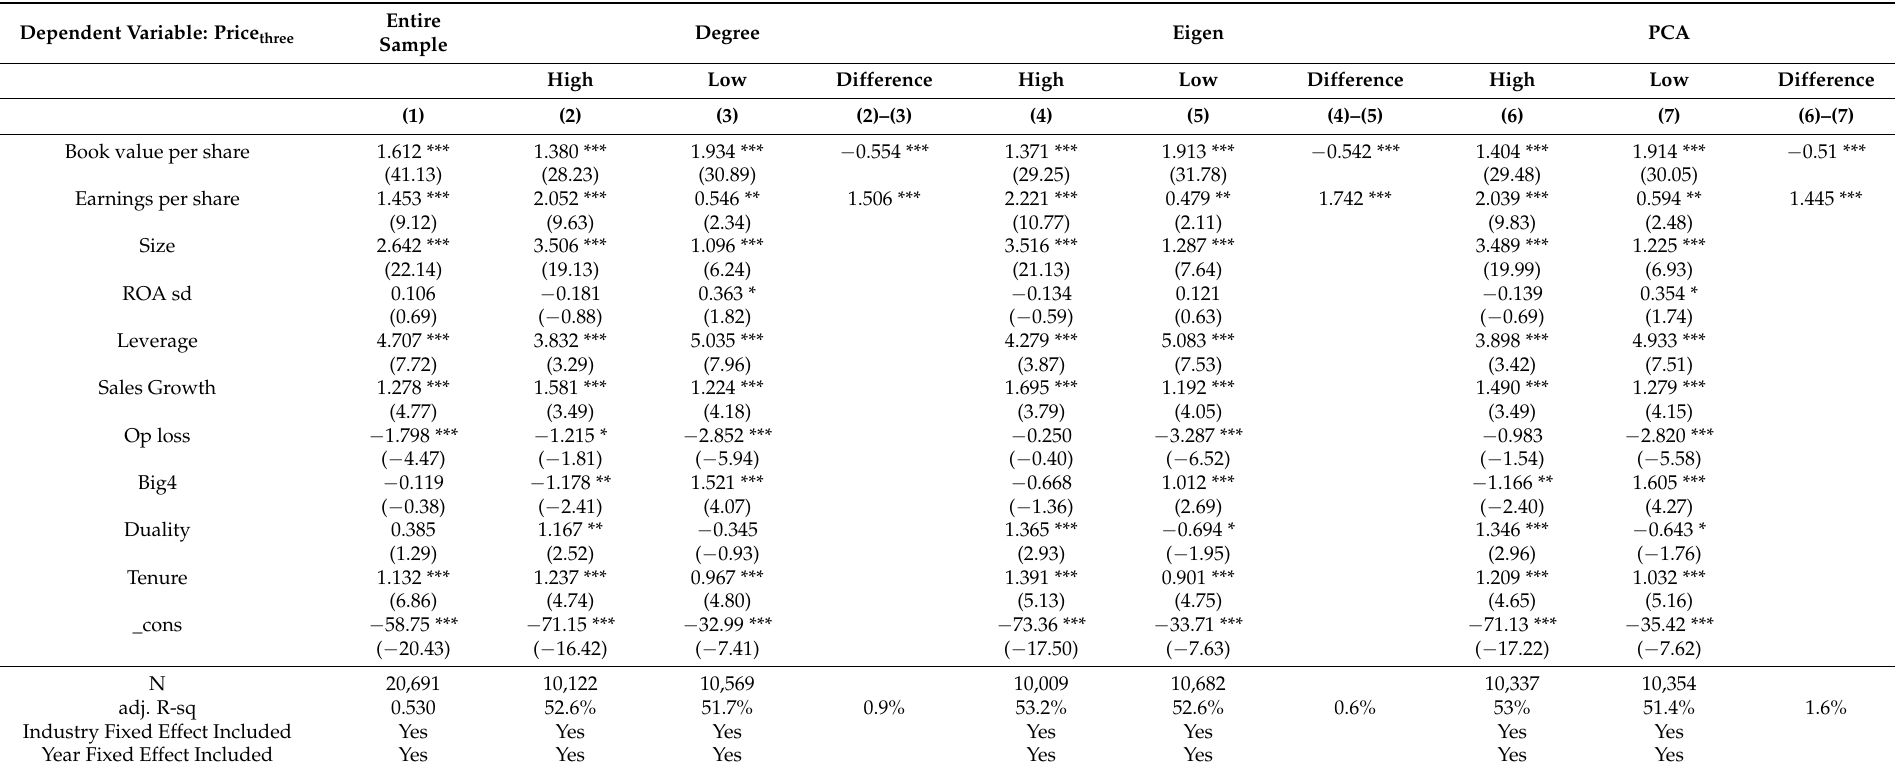
Table 3. CEO social capital and the value relevance of accounting metrics. This table presents the results of the OLS regressions, explaining the effect of CEO social capital on the value relevance of book value of equity and earnings metrics. The dependent variable is Price three , a continuous variable measured by the market price of the common equity at the end of three months after fiscal year-end. CEO social capital is measured by Degree in columns (2) and (3), Eigen in columns (4) and (5) and PCA in columns (6) and (7); variables of interest in the regression include Book value per share (book value of common equity scaled by number of shares outstanding) and Earnings per share (net income scaled by number of shares outstanding). All regressions include control variables as defined in Appendix A. All regressions include time- and industry-fixed effects and the errors are robust to firm heteroscedasticity. T-values are reported in parentheses. Statistical significance of the coefficients is designated as ***, ** and * at 1%, 5% and 10% levels,